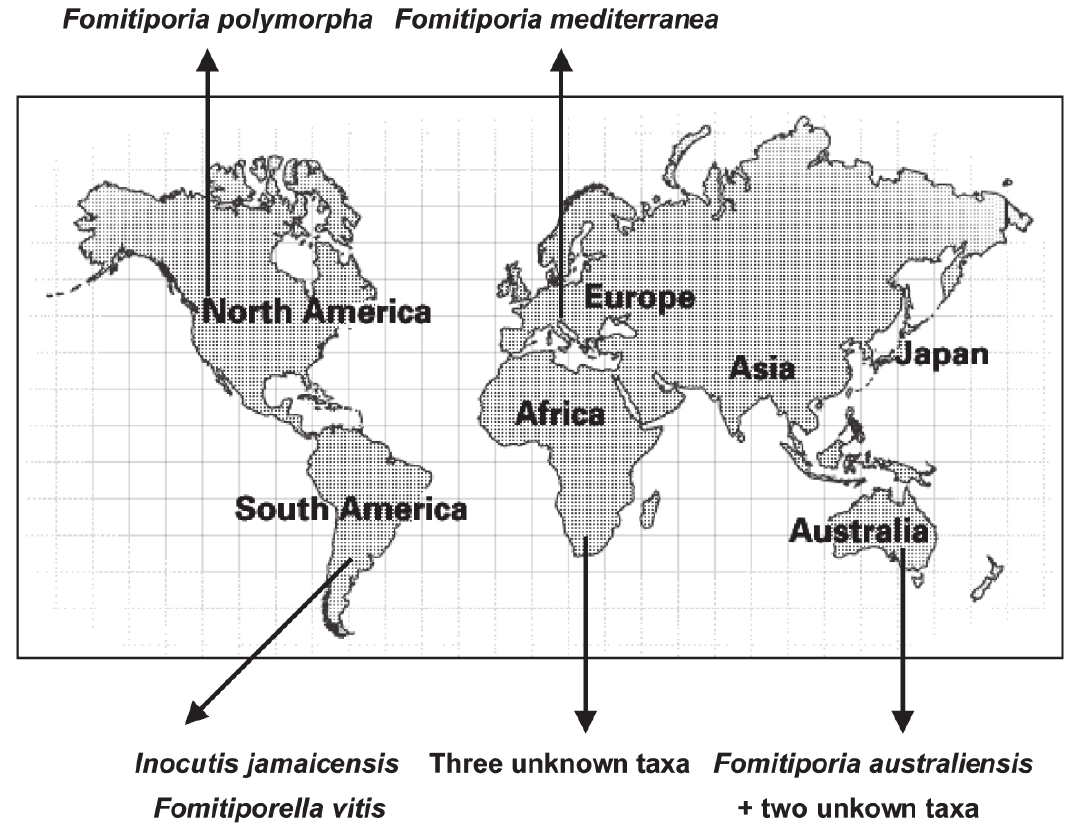
Fig. 2. Biodiversity and geographic distribution of white rot basidiomycetes associated with esca of